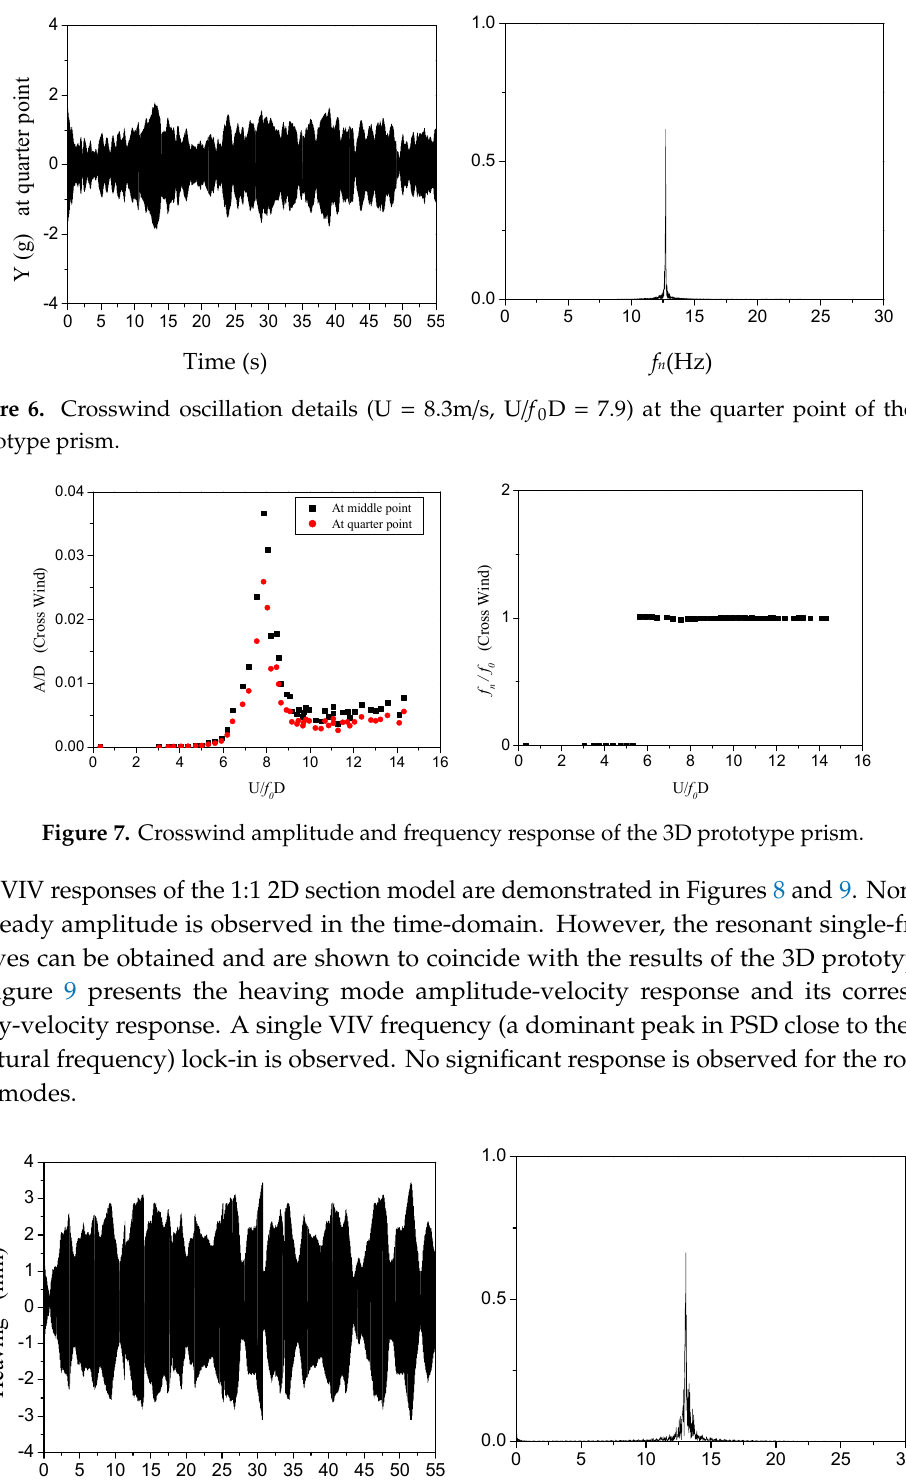
Figure 5. Crosswind oscillation details (U = 8.3m/s, U/ f 0 D = 7.9) at the middle point of the three- dimensional (3D) prototype prism.